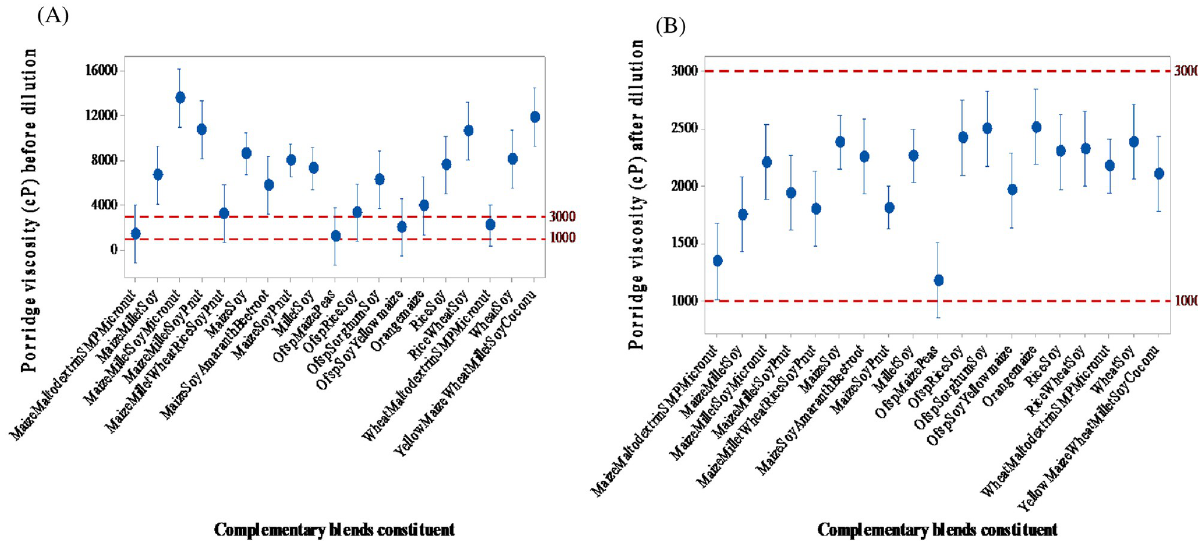
Fig 1. (A) Viscosity of commercial complementary blends before dilution and (B) the viscosity of commercial complementary blends after dilution.